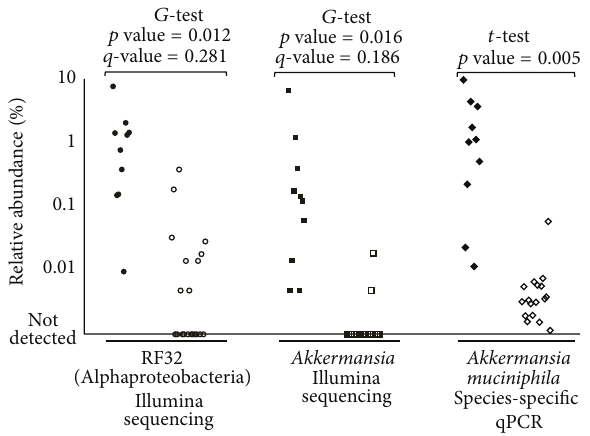
Figure 5: Bacterial prevalence in mice with high and low histo- pathology scores. Filled marks illustrate scores between 6 and 24, while empty marks illustrate those between 0 and 2. Sam- ples in which RF32 (Alphaproteobacteria), Akkermansia (Illumina sequencing), and A. muciniphila (species-specific qPCR) were detected are represented by their relative distribution. Samples that were negative (no bacteria detected) are depicted at the no detection line. 𝑞 -values were determined with the False Discovery Rate correction method.